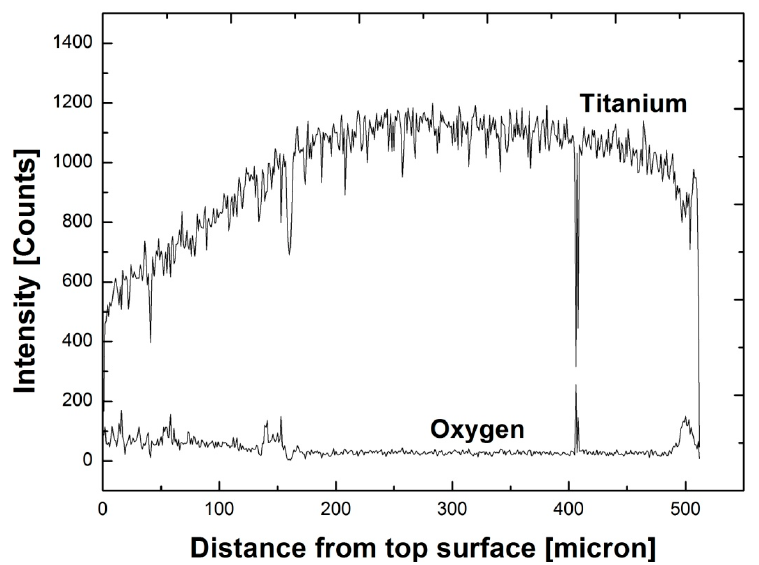
Figure 3. Titanium and oxygen intensity along the scan line indicated in Figure 1.